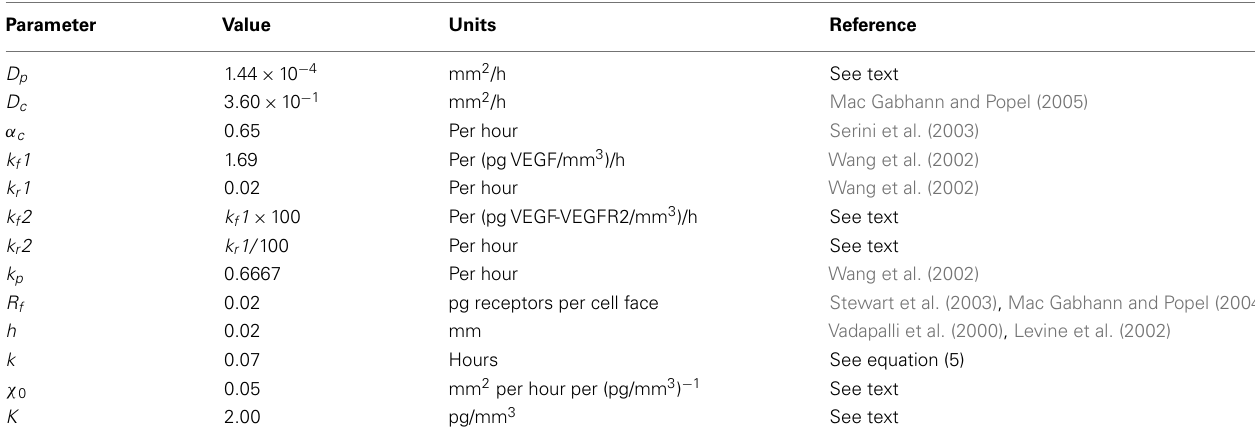
Table 2 | List of parameter values for single cell